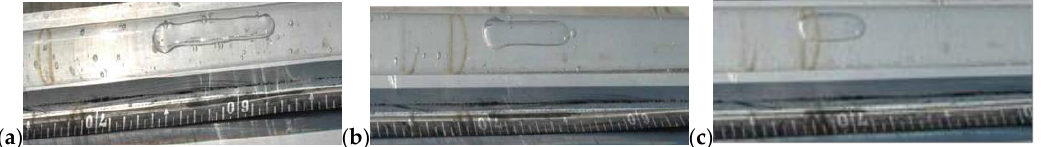
Figure 5. Flow state in the middle part of the pipe under various gradients: ( a ) i = 0, ( b ) i = − 1/60, ( c ) i = − 1/30.